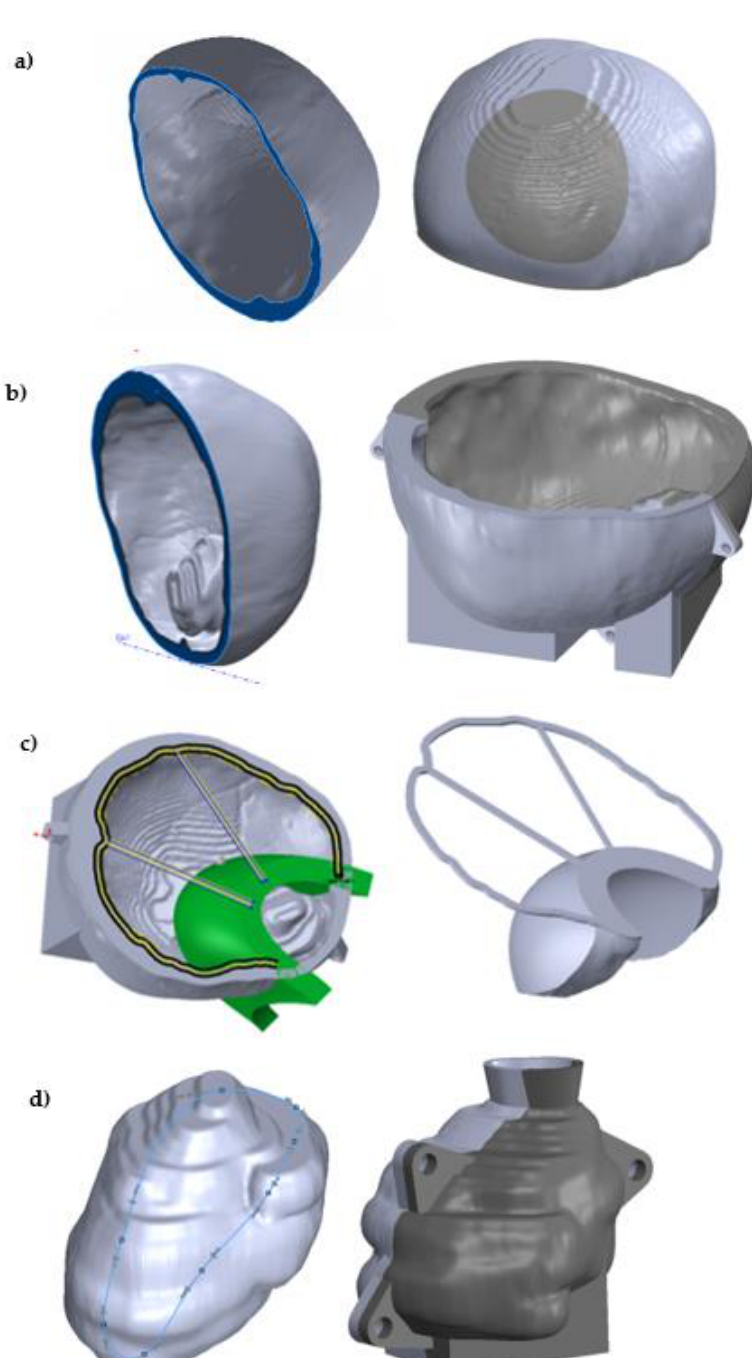
Figure 5. Features performed in SolidWorks to obtain the skull ( a ), the brain mold ( b ), the mold to define the working area inside the brain mold ( c ), and the tumor mold ( d ).